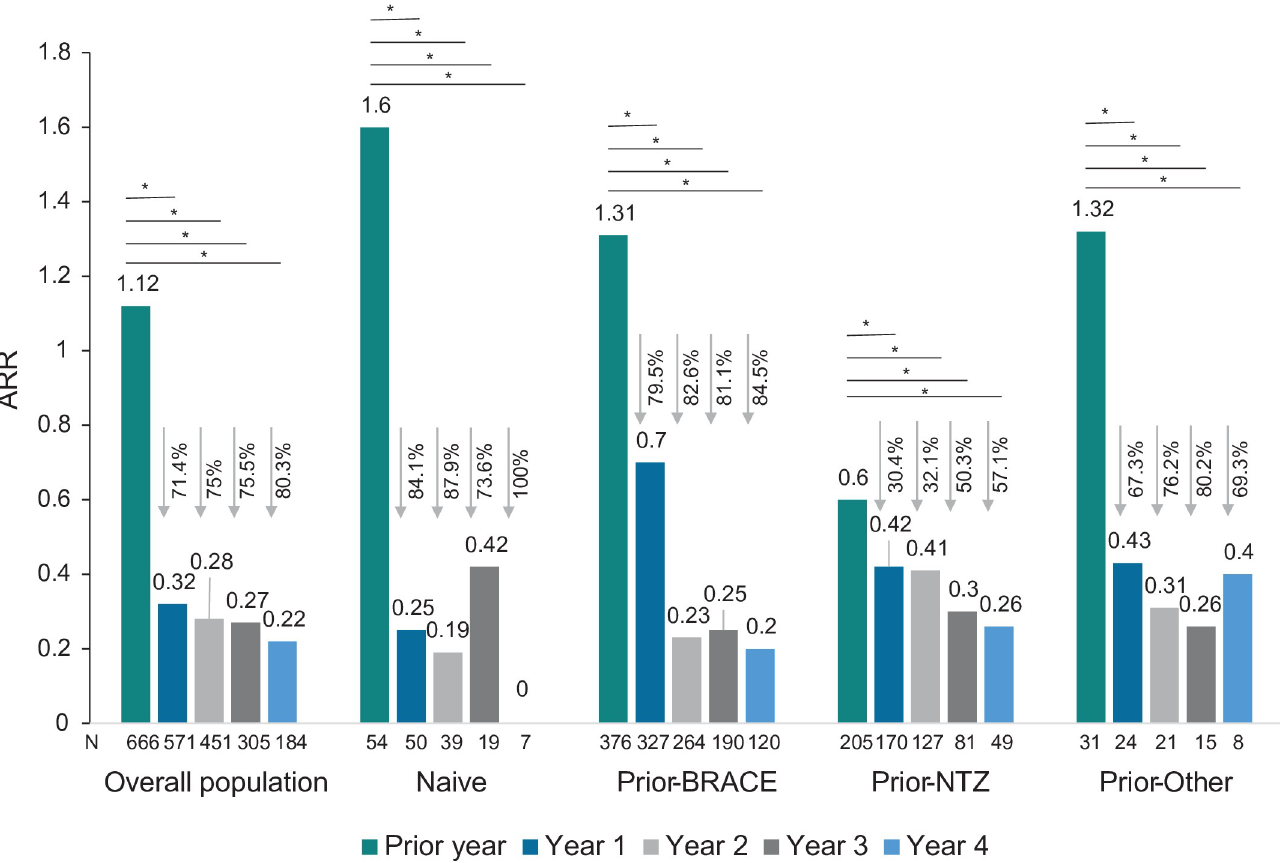
Fig 1. ARR in the overall population and prior treatment subgroups. Abbreviatures : BRACE: Betaseron (interferon beta-1b sc), Rebif (interferon beta-1a sc), Avonex (interferon beta-1a im), Copaxone (Glatiramer acetate), and Extavia (interferon beta-1b sc); EDSS, Expanded Disability Status Scale; IQR, interquartile range; N: Number of patients with available data for relapses; NTZ, natalizumab.